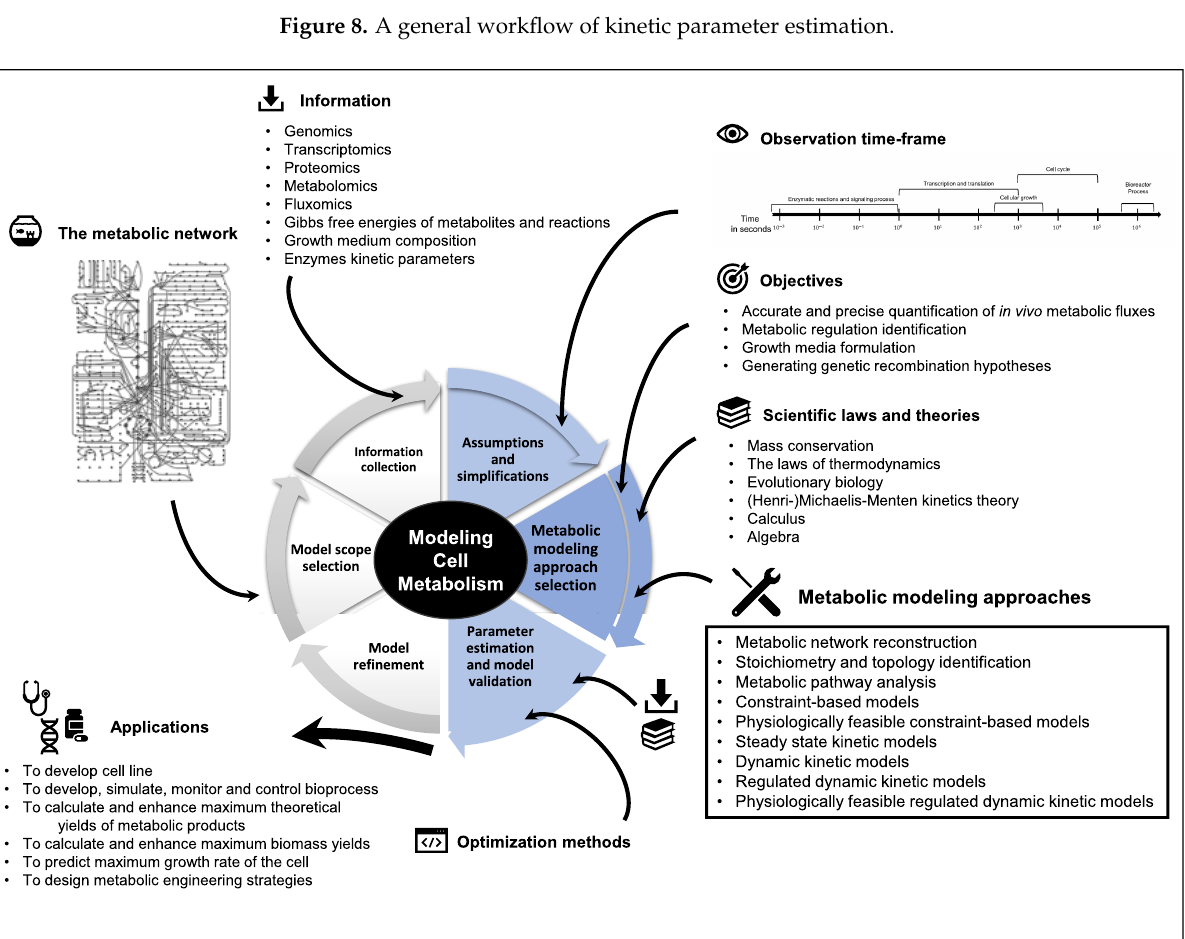
Figure 9. An overview of modelling Cell